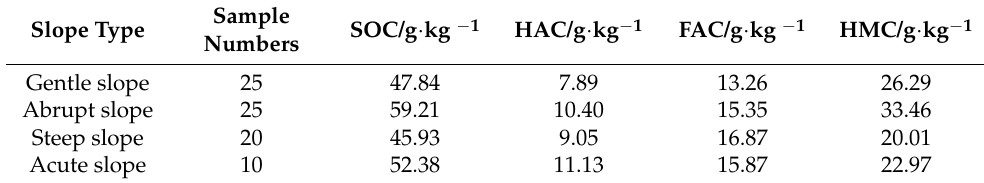
Table 1. Characteristics of soil organic matter composition in different slope forest soils.